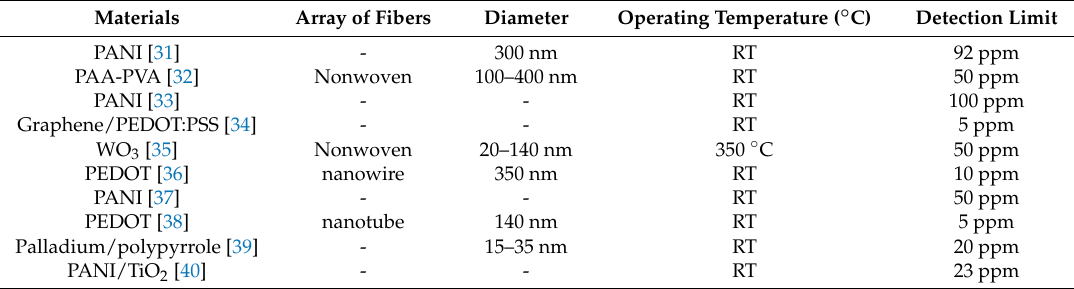
Table 1. Sensors based on nanomaterials detects